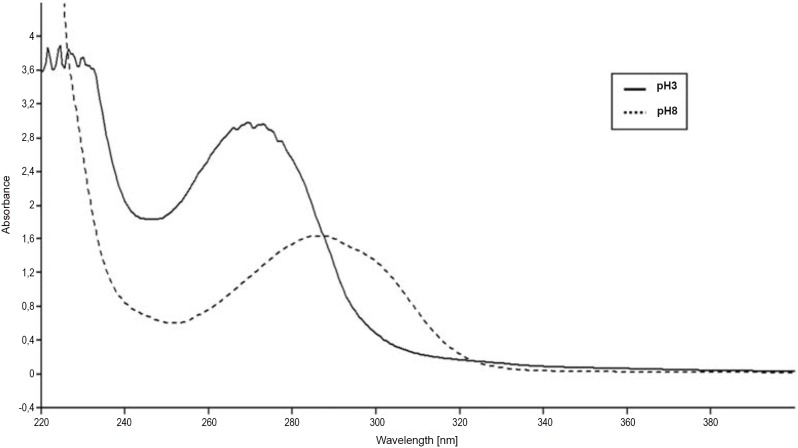
Absorbance spectrum of non-irradiated (control) egg extracts at pH8 (dotted line) and pH3 (solid line).Wavelengths cover almost the entire UV spectrum (UVC: 200–280 nm, UVB: 280–315 nm, and UVA: 315–400 nm). Absorption is shown as arbitrary units.